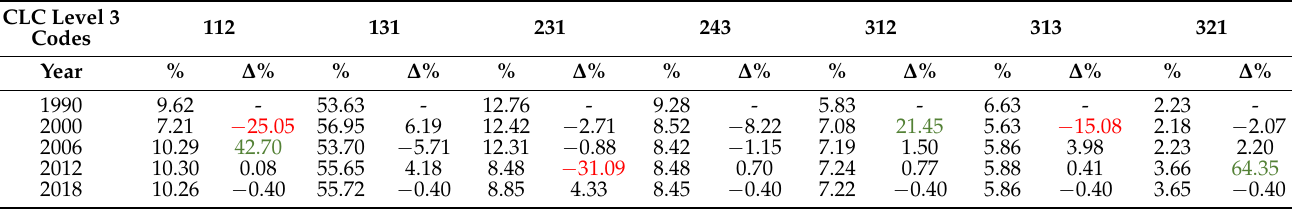
Table 3. Total percentage changes in the individual CLC